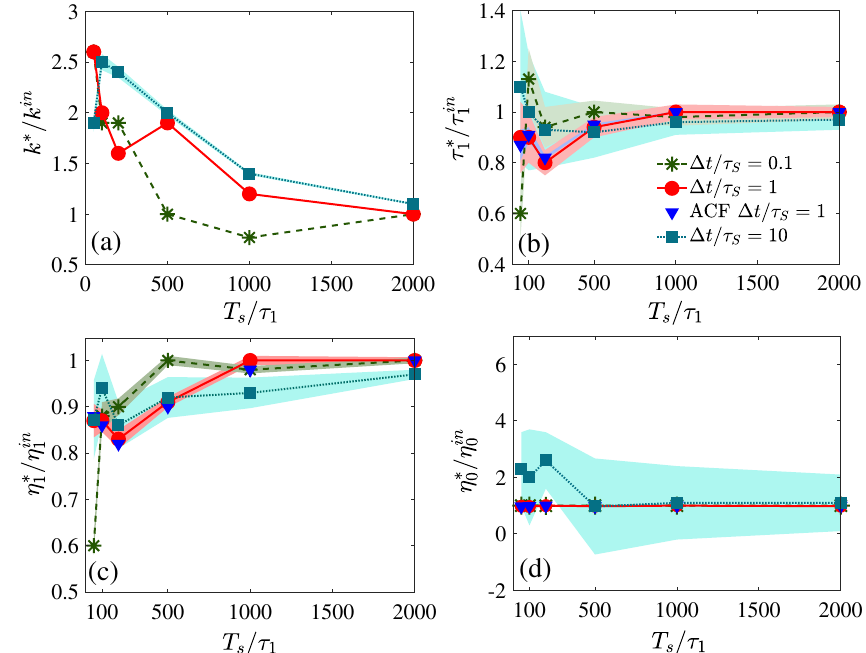
in 0.1 µ N/m) = in 1 s, ( c ) the polymer 1 = in 0.001 0.1 Pa s, ( d ) the solvent viscosity normalized by η in 0 = 1 =